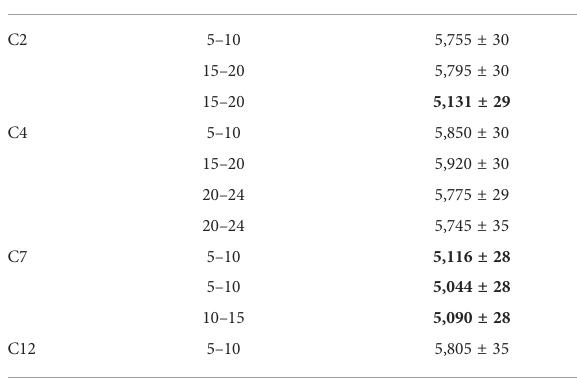
TABLE 2 Radiocarbon ages (in years before present (BP)) of wood material collected from Zostera marina seagrass-vegetated sediment cores in Sierksdorf, Luebeck Bay, in northern